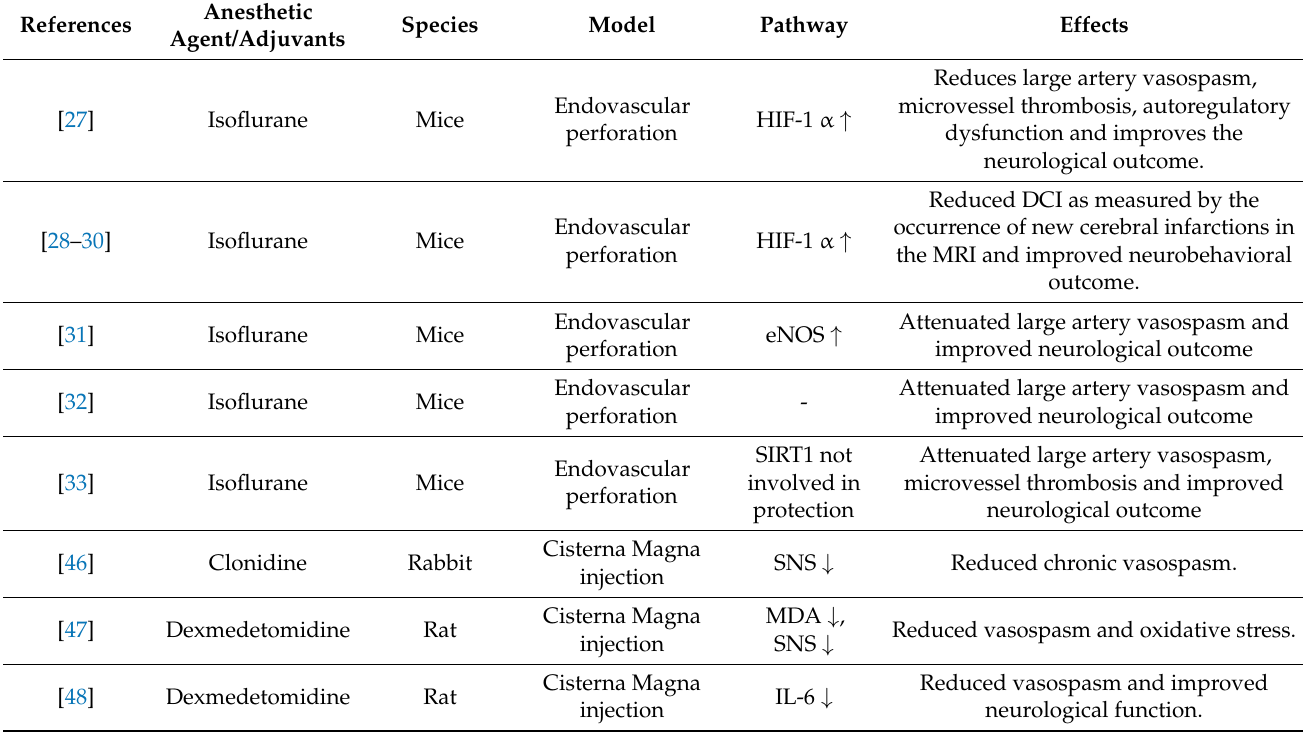
Table 3. Anesthetics and adjuvants in delayed cerebral ischemia (DCI) after SAH in experimental studies.